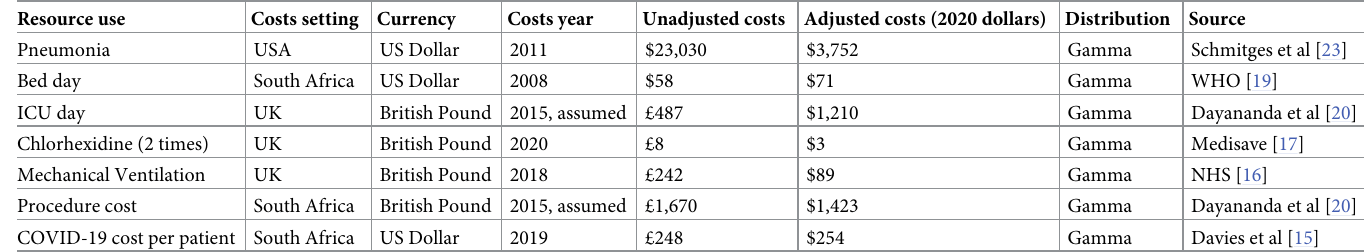
Table 2. Model input